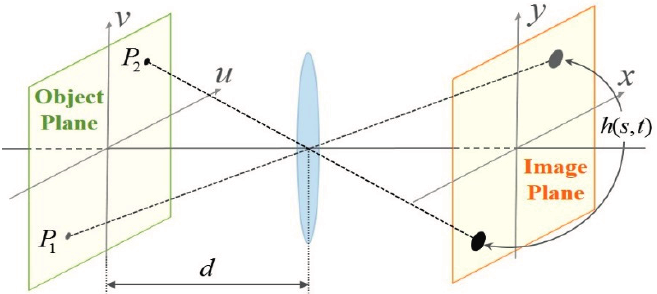
Figure 2. An image formation model of an object plane with distance d from the lens. The point spread function (PSF) is invariant throughout the image